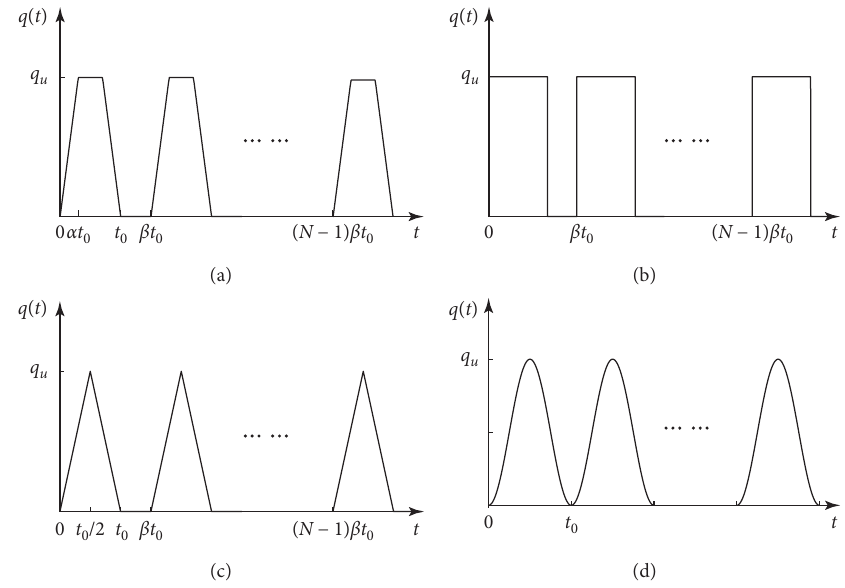
Figure 2: Various cyclic loadings: (a) trapezoidal cyclic loading; (b) rectangular cyclic loading; (c) triangular cyclic loading; (d) haversine cyclic